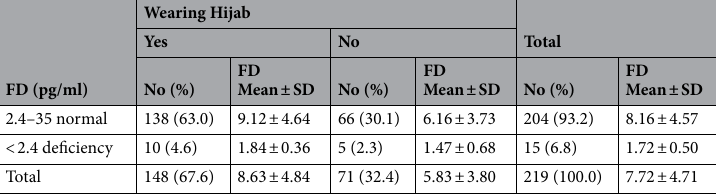
Table 9. Mean and standard deviation of Free 25-OHD level in respect to dress style. P-value = 0.006.